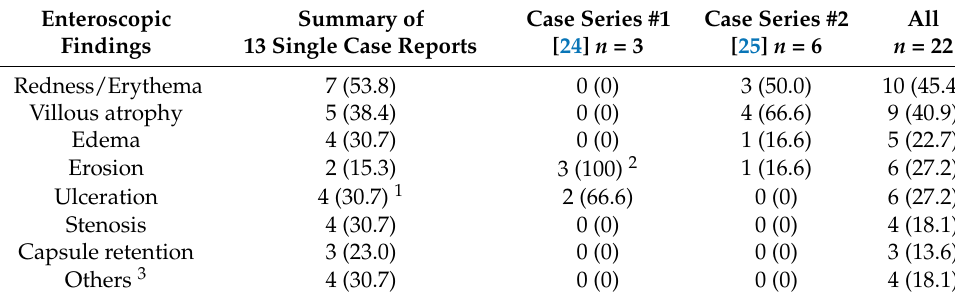
Table 2. Characteristics of enteroscopic findings of